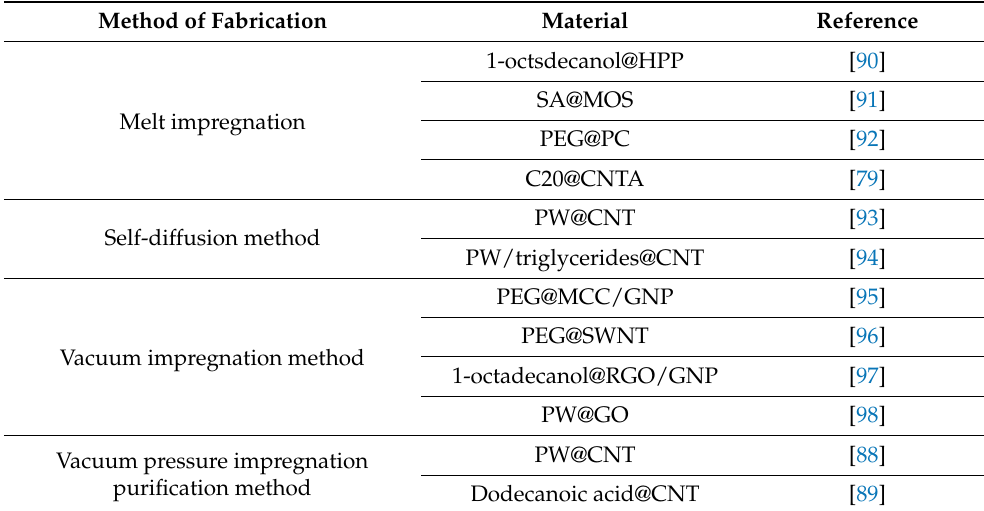
Table 3. Summary of some examples of PCCs by impregnation methods.